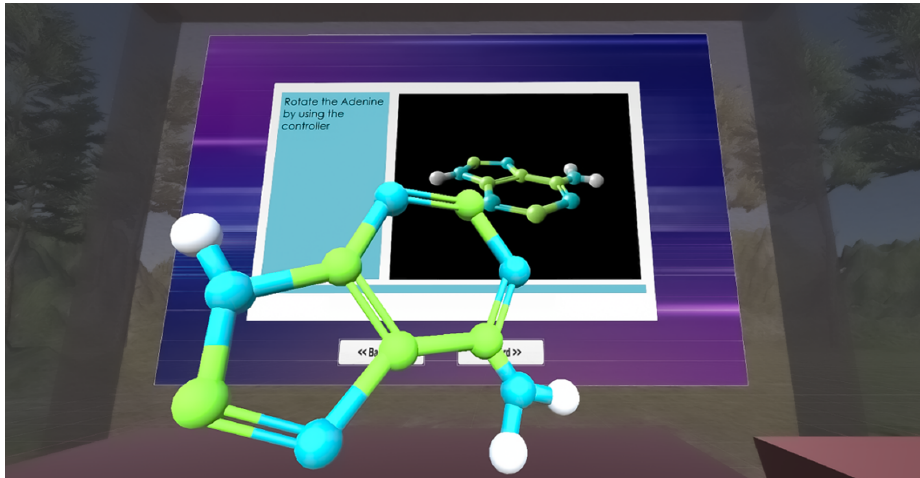
Figure 2. Examples of content for desktop screening: 3D representation of sugar.